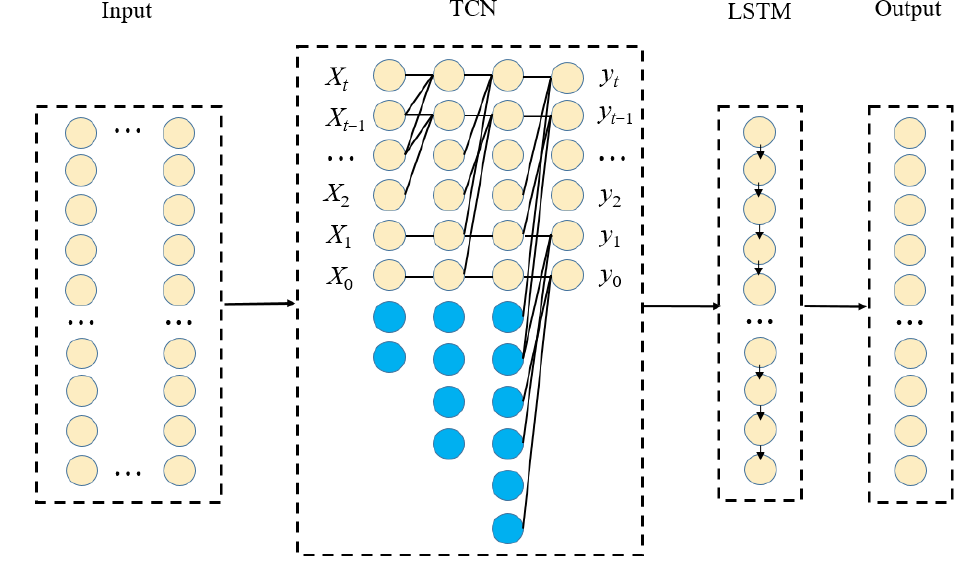
Figure 5. Structure diagram of TCN-LSTM model.